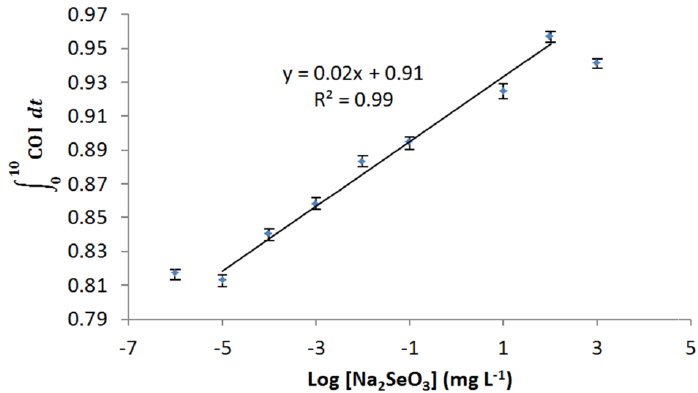
Figure 7. Dynamic range of E. coli roGFP2 oxidative stress biosensor towards the exposure 10 of Na 2 SeO 3 (1 ng·L −1 –1000 mg·L −1 ). ∫ COI 𝑑𝑡 indicates the total COI response of biosensor 0 in 10 min. Error bars indicate the values of standard deviation ( n = 8). The